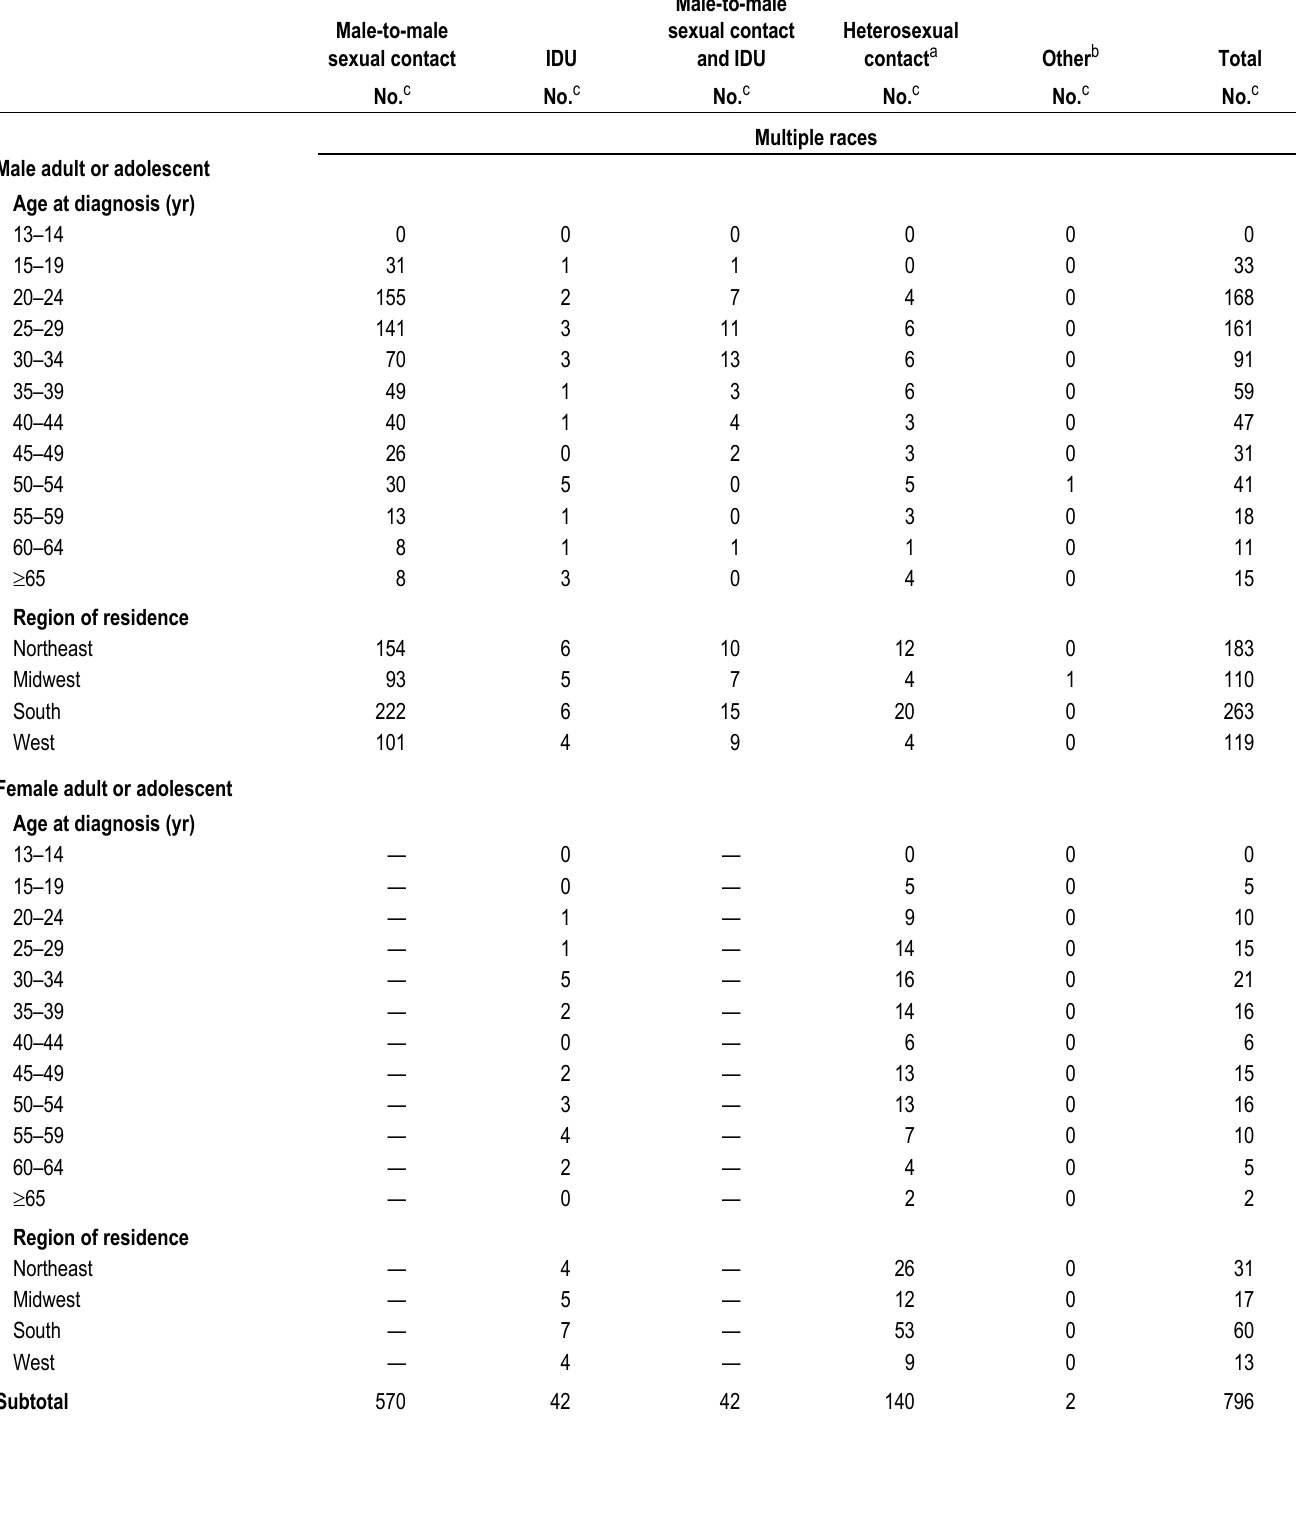
Table 5a. Diagnoses of HIV infection, by transmission category, race/ethnicity, and selected characteristics, 2015—United States